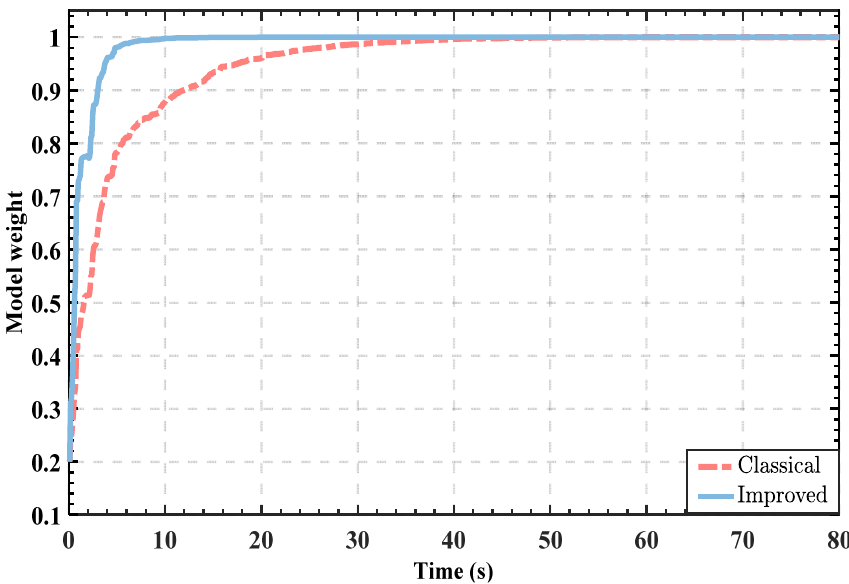
Figure 4. Weight change of the optimal model.